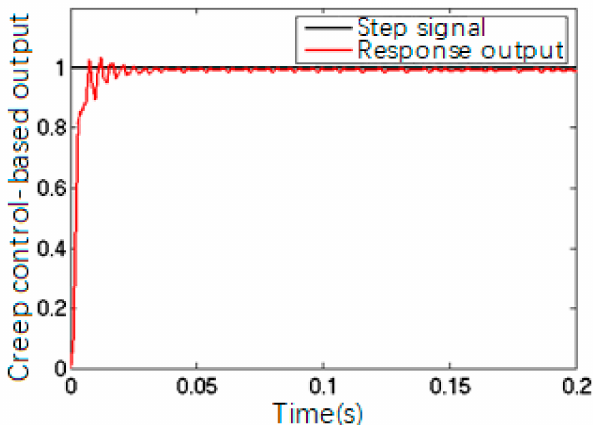
Figure 11. Output of the closed-loop control based on creep